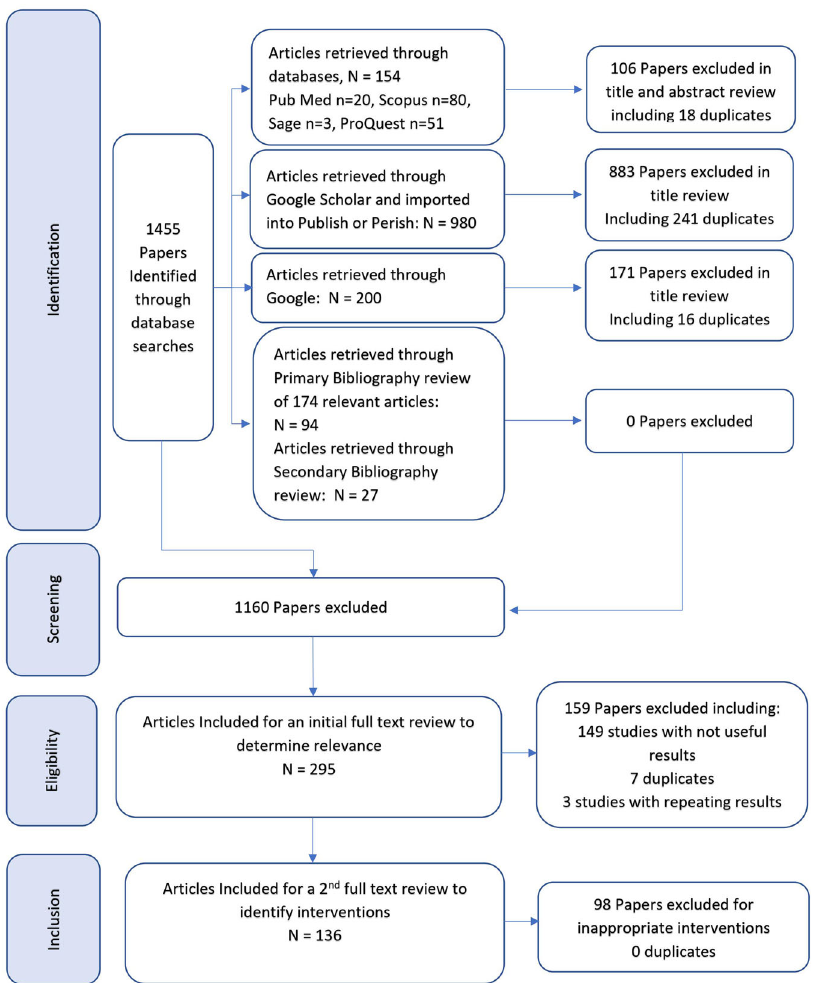
Fig. 1 The fl owchart demonstrates the research, identi fi cation, and screening process. A total of 1455 papers were originally identi fi ed and screened resulting in 38 papers being included that examined 45 interventions.